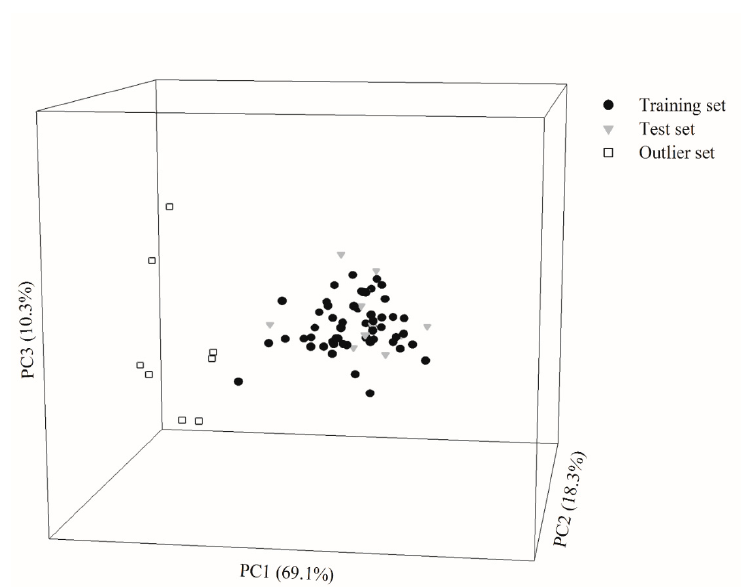
Figure 1. Molecule distribution for the molecules enrolled in this investigation in the training set (solid circle), test set (gray triangle), and outlier set (open square) in the chemical space spanned by three principal components.